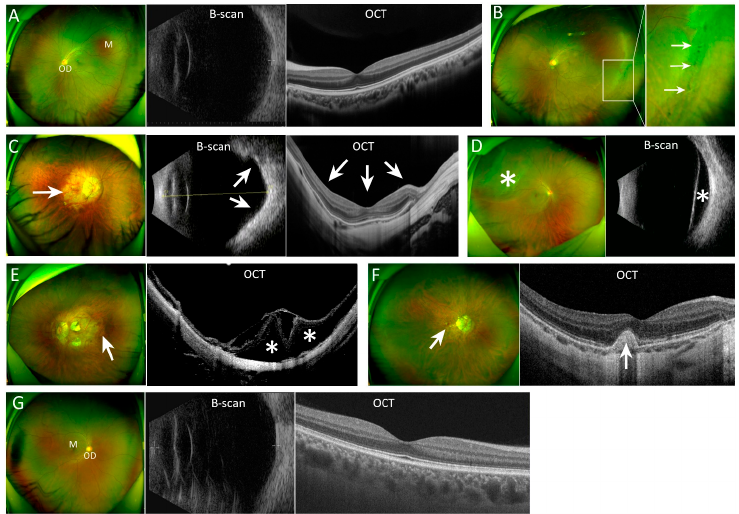
Figure A1. Representative images of different groups of participants. ( A ) Fundus image, B ‐ scan and OCT images of the left eye of an 18 ‐ year ‐ old female with simple high myopia (axial length was 27.5 mm, myopic diopter was 6.25 D). ( B ) Fundus images of the left eye of a 33 ‐ year ‐ old female with lattice degeneration (arrows in enlarged image) (axial length = 26.4 mm, myopic diopter = 8.75 D). ( C ) Fundus image, B ‐ scan and OCT images of the right eye of a 38 ‐ year ‐ old female with posterior staphyloma (arrows) (axial length = 31.3 mm, myopic diopter = 24.5 D). ( D ) Fundus image and B ‐ scan image of the right eye of a 38 ‐ year ‐ old female showing retinal detachment (asterisks) (axial length = 31.3mm, myopic diopter = 24.5 D). ( E ) Fundus image and OCT image of the left eye of a 42 ‐ year ‐ old female with myopic maculopathy including macular oedema and detachment (arrow in colour funds image and asterisks in OCT image) (axial length = 31.45mm, myopic diopter = 25.0 D). ( F ) Fundus image and OCT image of the right eye of a 37 ‐ year ‐ old female with myopic choroidal neovascularization (arrows) (axial length = 29.5 mm, myopic diopter = 12.0 D). ( G ) Fundus image, B ‐ scan and OCT images of the right eye of a 28 ‐ year ‐ old male with emmetropia (axial length was 25.7 mm, myopic diopter was 0.25 D, uncorrected visual acuity was 1.0). OD, optic disc; M, macula; OCT, optical coherence tomography.